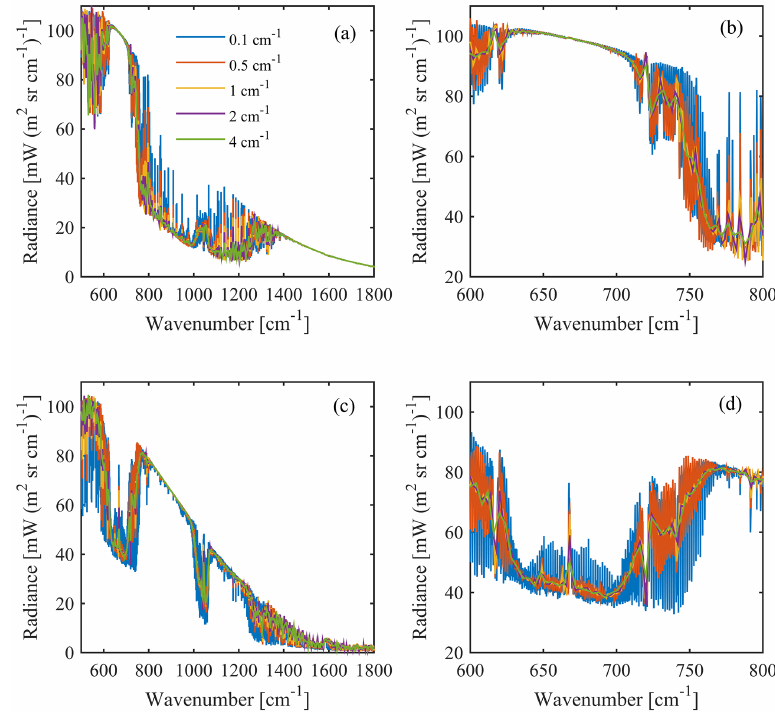
Figure 9. Simulated downwelling radiances from 500 to 1800cm − 1 for an example case ( τ = 0 . 65) from the perspective of the surface (a, b) and simulated upwelling radiances from same case from the perspective of the top of the atmosphere (c, d) . The top row (a, c) and the bottom row (c, d) each show the same data, but with the x axis narrowed to 600–800cm − 1 to illustrate the wing of the 15µm CO 2 band, where there is considerable spectral structure. In each panel the 0.01cm − 1 spectral resolution base data are convolved to 0.1cm − 1 (blue), 0.5cm − 1 (red), 1cm − 1 (yellow), 2cm − 1 (purple), and 4cm − 1